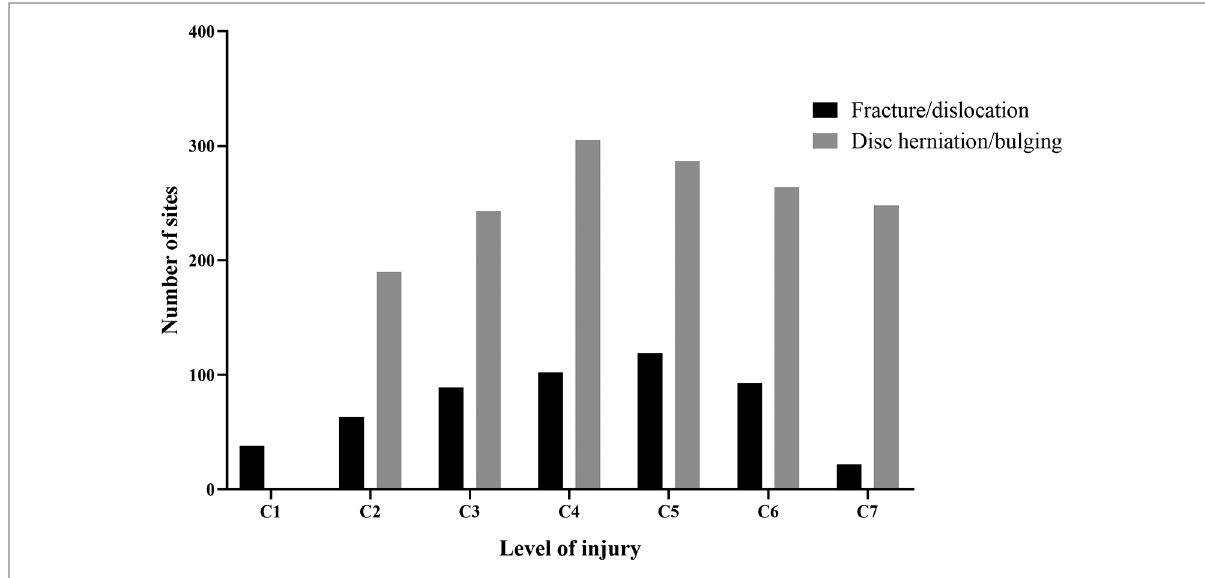
FIGURE 6 Distributions of all sites of injury (C1 – C7) caused by fracture/dislocation and disc herniation/bulging.